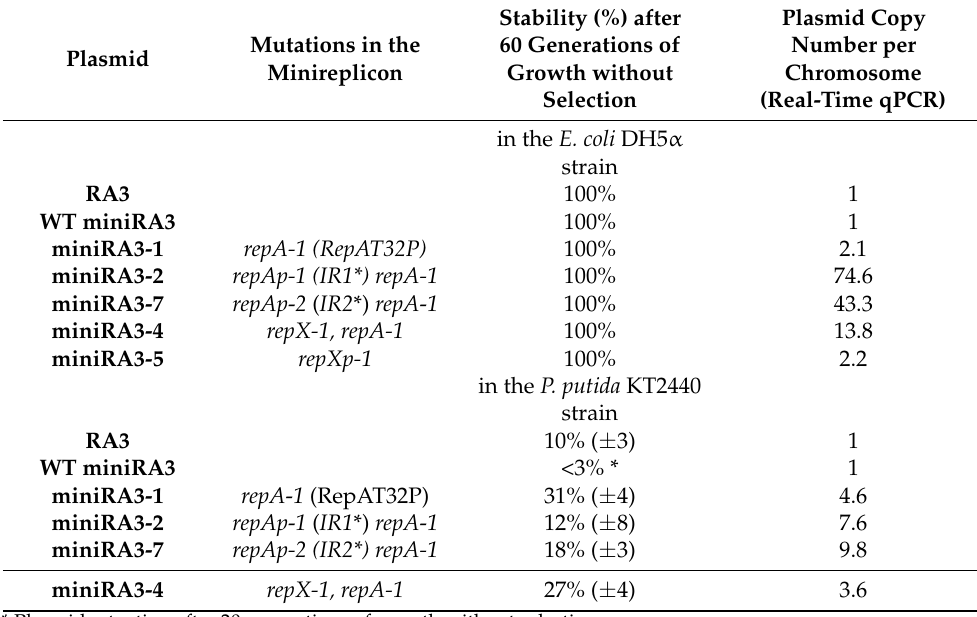
in the P. putida KT2440